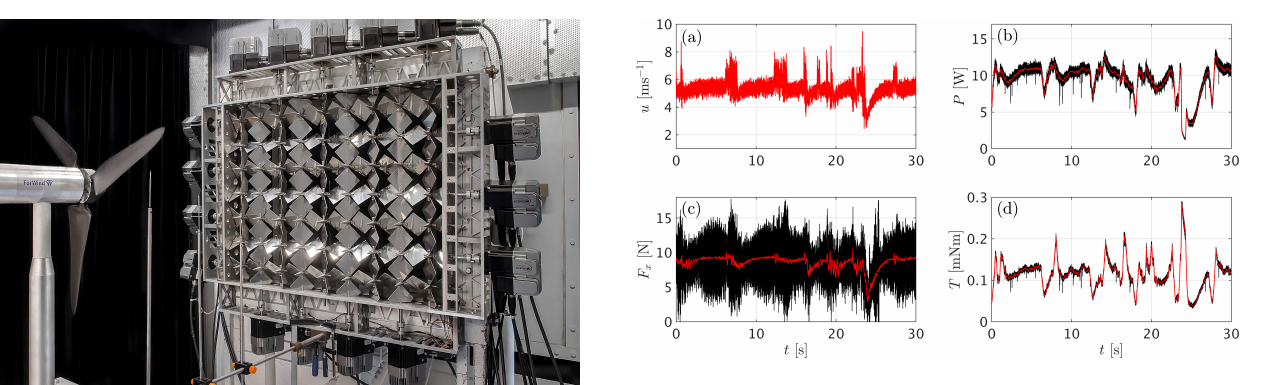
Figure 4. Original (black) and filtered (red) example time series of the wind speed (a) , power (b) , thrust force (c) and torque (d) . The wind speed was filtered using a sixth-order Butterworth low-pass filter at 2kHz. In a similar way, the power and torque signals were filtered at 45Hz and the thrust force at